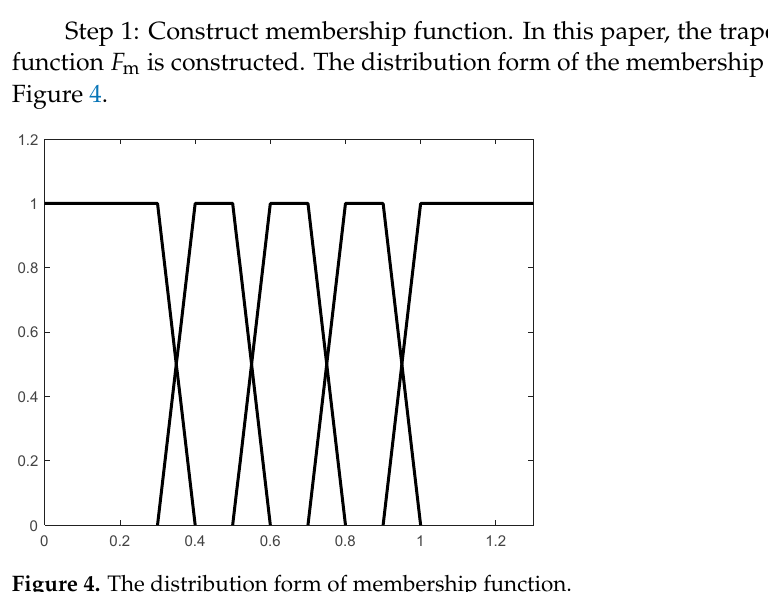
Figure 4. The distribution form of membership function.